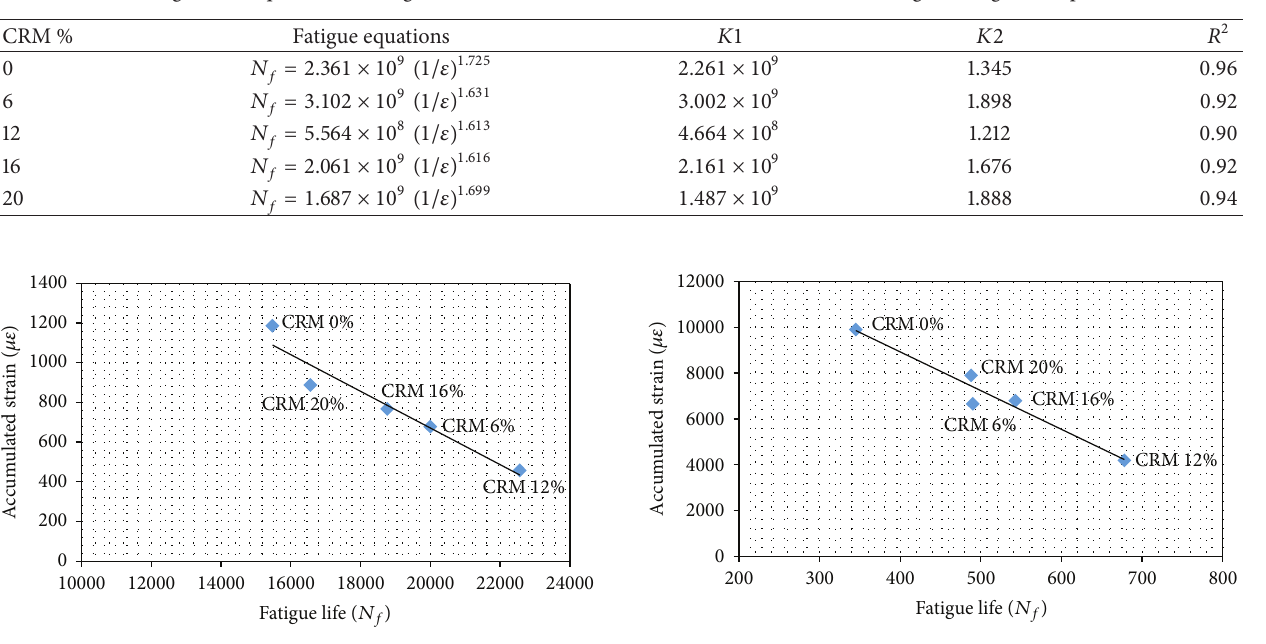
Table 6: Regression equations for fatigue life due to the variation of CRM content at OBC along with regression parameters.